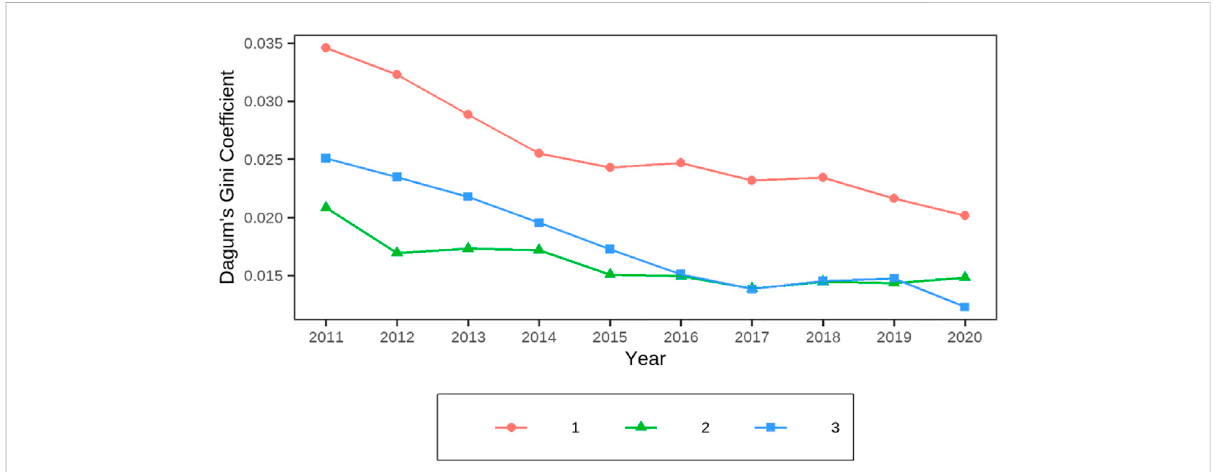
FIGURE 4 Changesinintra-regionaldisparitiesinthelevelofhigh-qualityeconomicdevelopmentofthethreemajorurbanagglomerationsintheYangtze